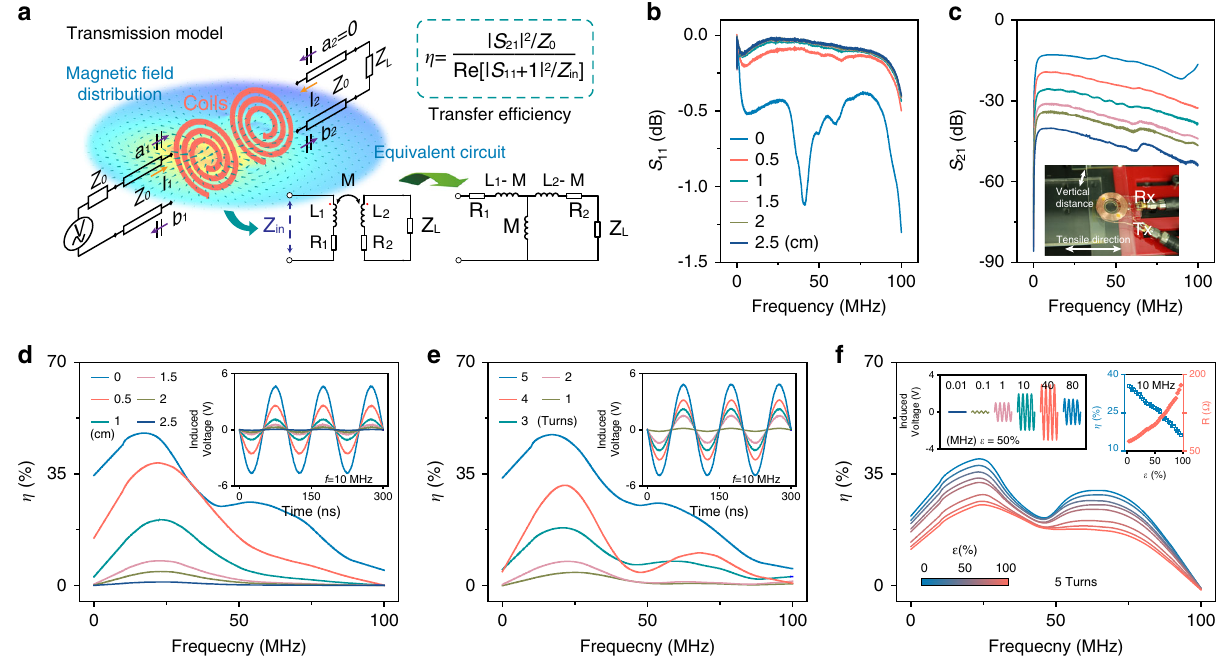
Fig. 5 Wireless power transfer ef fi ciency of stretchable spiral coils. a Two-port network model analysis based on magnetic resonant coupling mode. Scattering parameters S 11 and S 21 and ef fi ciency η ( b – d ) between primary coil and stretchable coil at different vertical distances. Insets: photographs of coupling of two coils under testing ( c ); induced voltage of two coils with different vertical distances at 10 MHz ( d ). e Ef fi ciency η between primary coil and stretchable coils with different numbers of turns. Insets: induced voltage shown in e at 10 MHz. f Ef fi ciency η between primary coil and stretchable coils with tensile strain. Insets: induced voltage measured from stretchable coils with a tensile strain of 50% at different frequencies (left); ef fi ciency η and resistance R S versus tensile strain at 10 MHz